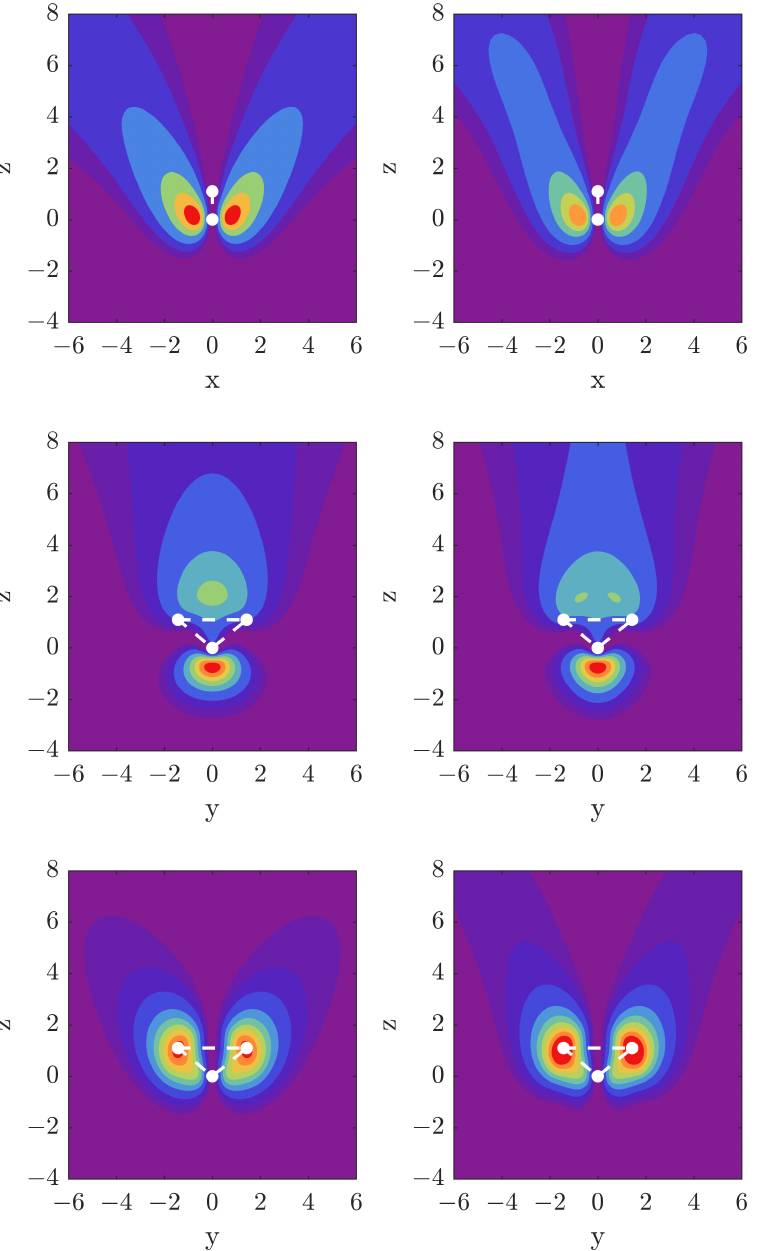
Figure 3. Probability densities using a z -directed force for the MOs 1 b 1 ( top row ), 3 a 1 ( middle row ), and 1 b 2 ( bottom row ). Left column is based on (cid:96) max = 3, right column for (cid:96) max = 4. The force strength for the MO 3 a 1 is 0.10 a.u., while for 1 b 1 and 1 b 2 it is 0.20 a.u. Contour heights starting with the outermost are 0.005, 0.01, 0.02, then they increase in steps of 0.02